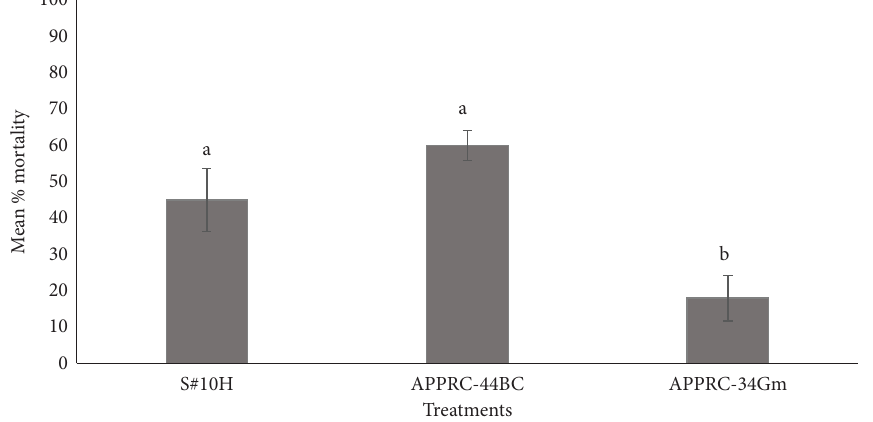
Figure 3: Mean percent mortality of C. partellus larvae after feeding on maize leave inoculated with entomopathogenic fungi